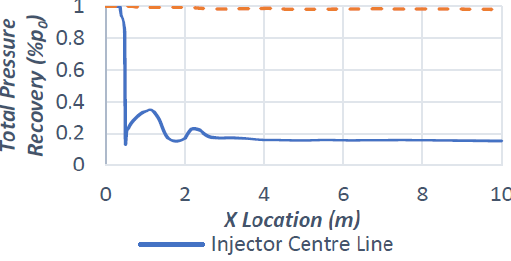
Figure 25. Total pressure loss across a twin strut injection combustor.